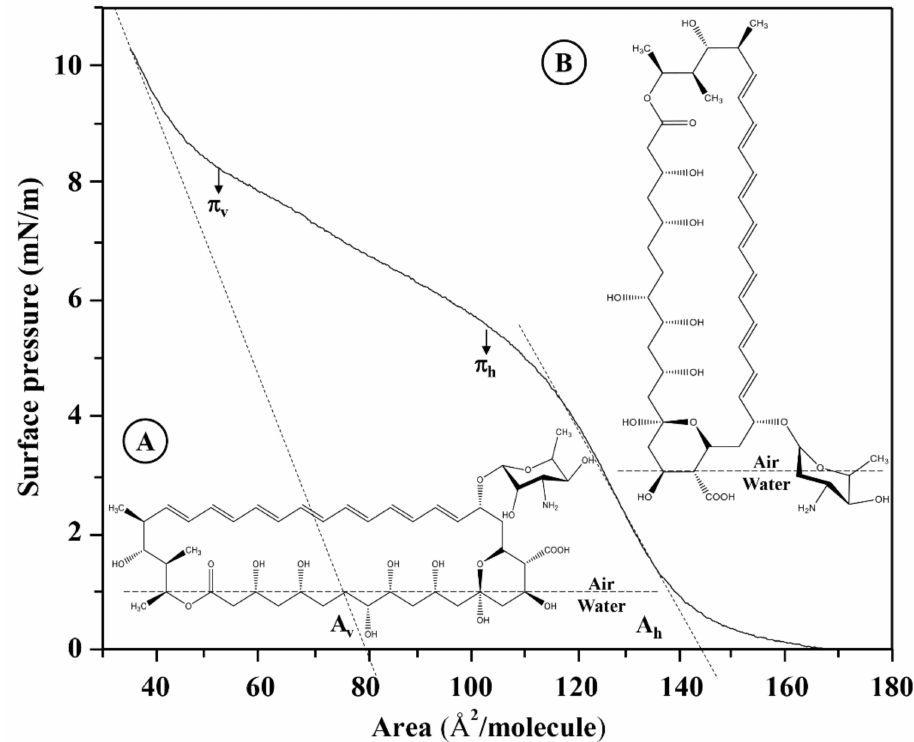
Figure 6. Surface pressure-area isotherms of AmB monolayers extended on Tris buffer 5 mM, pH = 7.4. The linear adjustments to the linear positions of the extrapolated compression isotherms to surface pressure zero point to the specific molecular areas in a horizontal position (A h ) and in a vertical position (A v ). The figure shows a subphase molecular reorientation model of AmB at a temperature of 37 ◦ C. Concentration is 0.447 mg/mL. ( A ) horizontal position (Ah); ( B ) vertical position